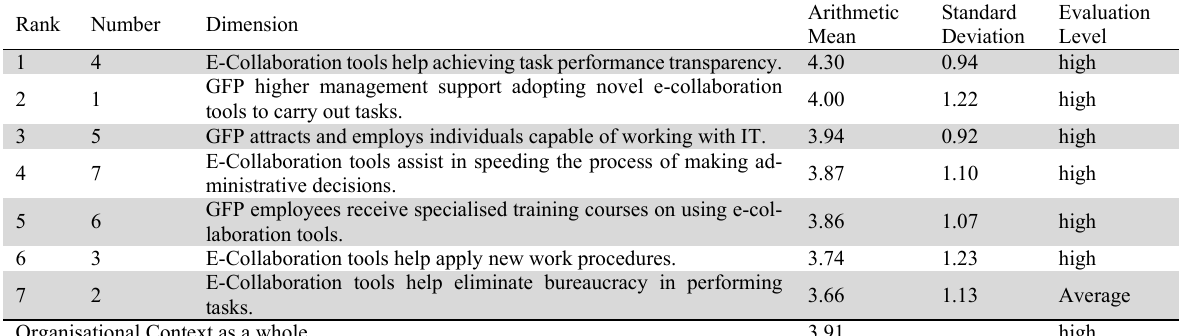
Arithmetic Means and Standard Deviations of Sample Responses Regarding the Organisational Context (in descending order by arithmetic